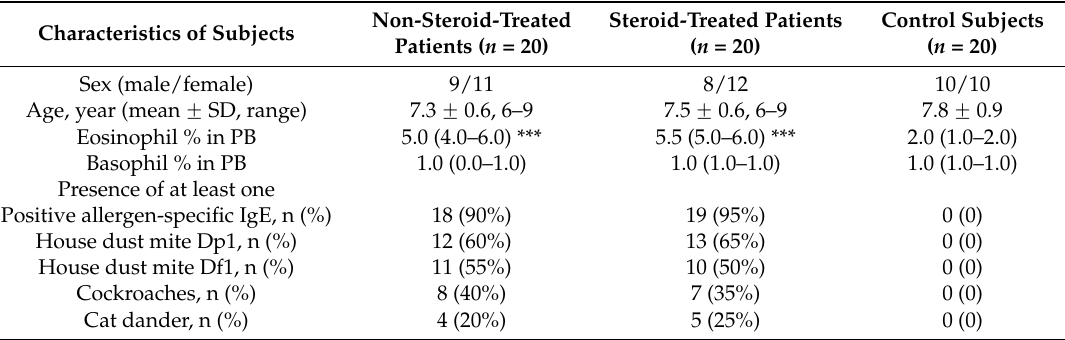
Table 1. Demographic, clinical and laboratory data of the asthmatic patients with or without steroid treatment and control subjects.